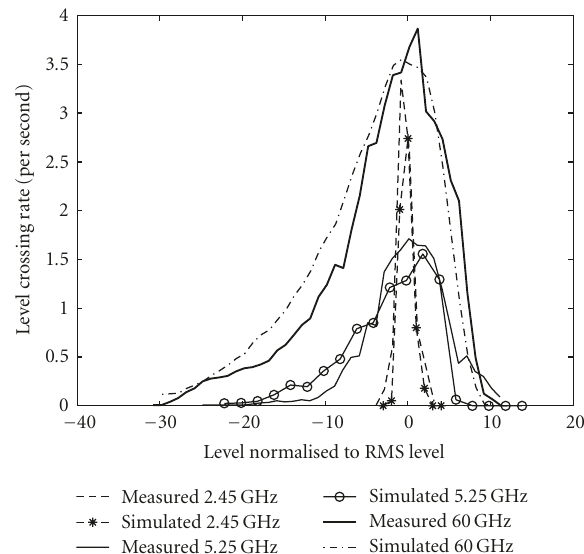
Figure 17: LCRs of measured (dry leaved deciduous trees (Site 1)) and simulated (using the new model) signals at 2.45, 5.25, and 60GHz during high ( w m = 5m/s) wind speed conditions. All simulation parameters are given in Table 3.